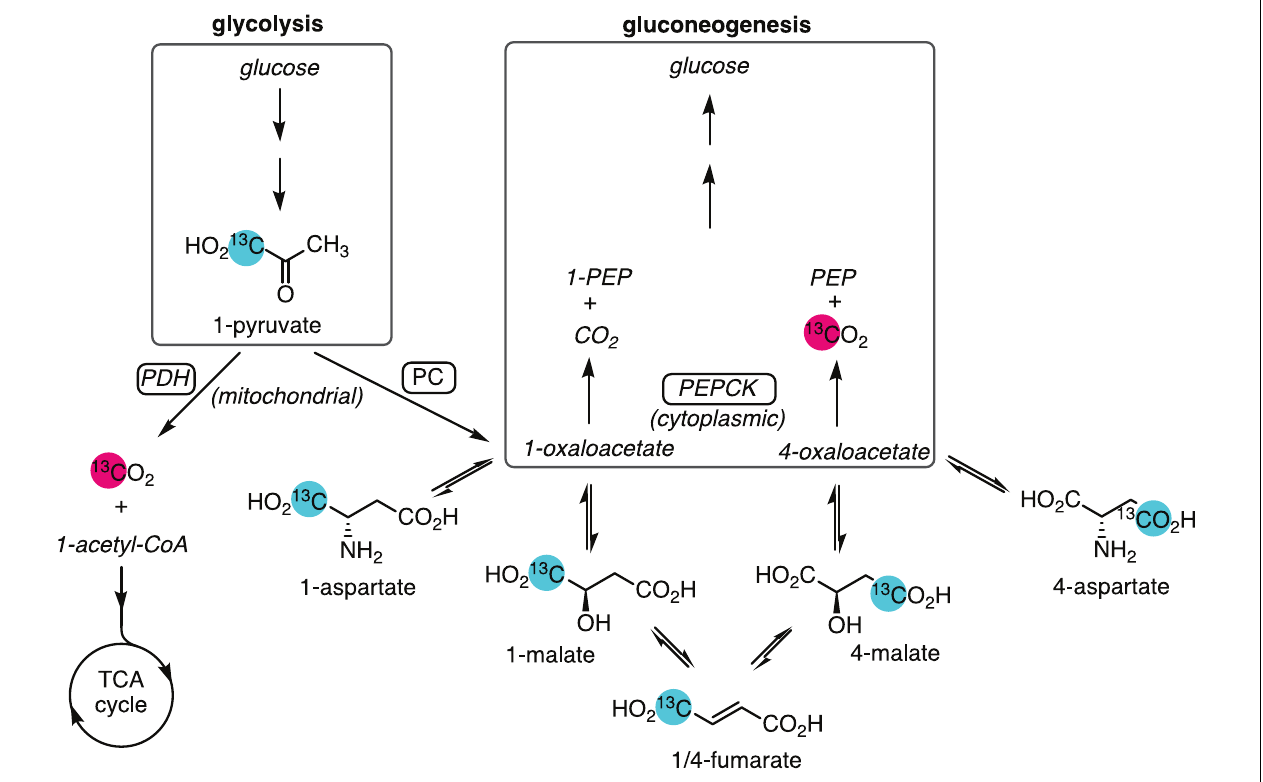
FIGURE 1 | Metabolic pathways yielding 13 C-labeled bicarbonate from hyperpolarized [1- 13 C]pyruvate. Pyruvate produced from glycolysis or lactate is oxidized by PDH and enters the TCA cycle, yielding [ 13 C]CO 2 , which is reversibly converted to [ 13 C]bicarbonate. Anaplerotic flux by PC in the mitochondrion converts [1- 13 C]pyruvate to [1- 13 C]oxaloacetate, which exchanges with the more abundant aspartate and malate pools. Dehydration of malate to fumarate and rehydration results in labeling the 4-carbon. Export to the cytosol via the malate–aspartate shuttle and conversion of [4- 13 C]oxaloacetate by gluconeogenic flux through PEPCK yields PEP and [ 13 C]CO 2 . Unobserved metabolites are rendered in italic text. Site of 13 C-labeling is indicated by the numeral preceding the metabolite